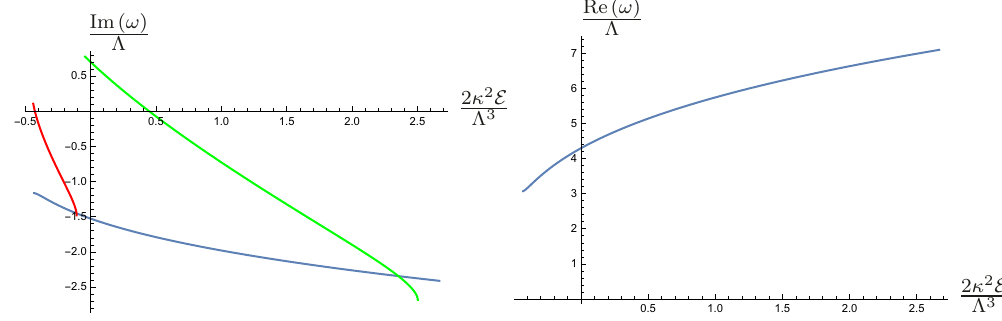
Figure 7 . Entropy density s sym of the Z 2 -symmetric phase, i.e., with a function of energy density (left panel). As the energy density is decreased below the critical one E crit , the symmetric phase becomes perturbatively unstable with respect to linearized E breaking fluctuations. The critical energy density for the onset of this instability as a function of the nonlinear coupling g (see (3.10)) (right panel).